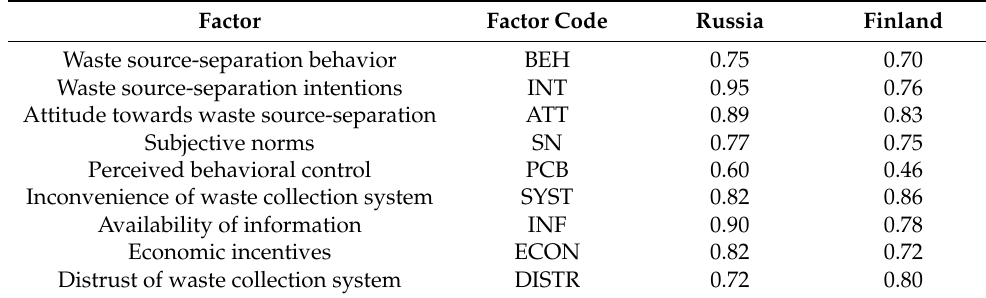
Table 2. Cronbach’s alpha for Russian and Finnish datasets.